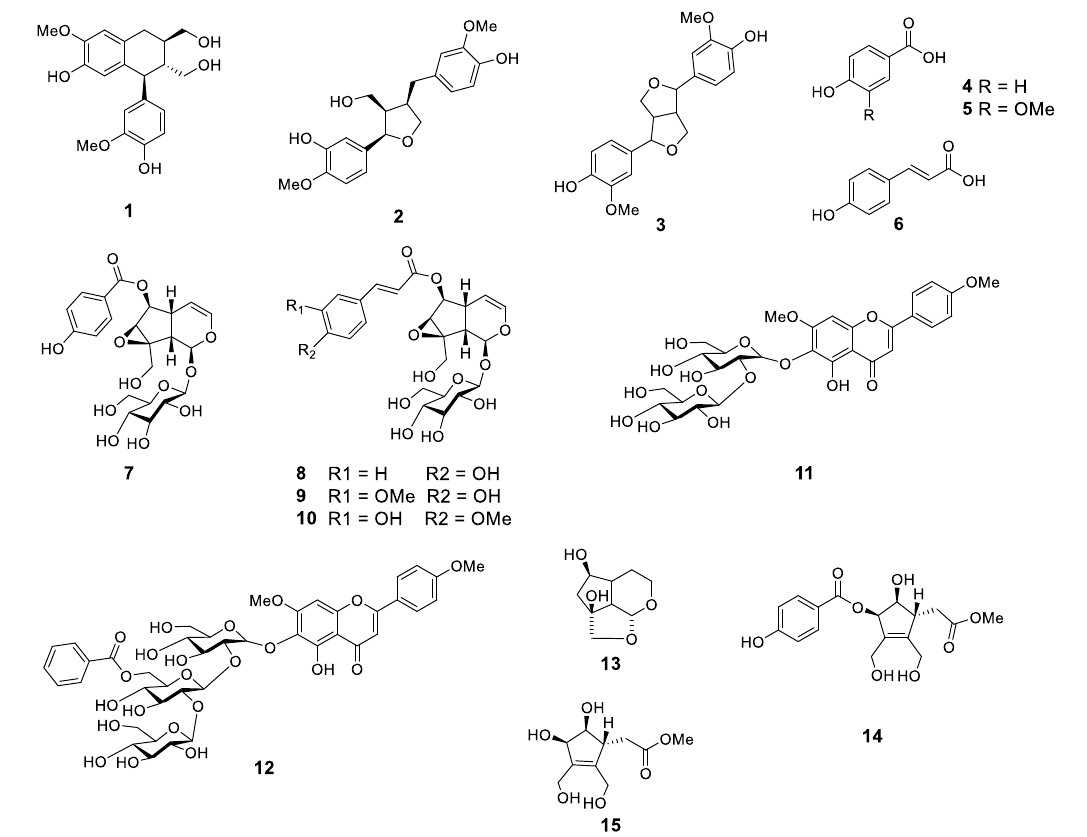
Figure 1. Chemical structures of compounds 1 – 15 . 1 , isolariciresinol; 2 , (+)-lariciresinol; 3 , pinoresinol; 4 , 4-hydroxybenzoic acid; 5 , vanillic acid; 6 , trans - p -coumaric acid; 7 , catalposide; 8 , specioside; 9 , 6- O - trans -feruloyl catalpol; 10 , minecoside; 11 , 5,6-dihydroxy- 7,4′ -dimethoxyflavone-6- O -sophoroside; 12 , 5,6-dihydroxy- 7,4′ -dimethoxyflavone-6- O -[6 ′′′ -benzoyl- β -D-glucopyranosyl-(1 → 2)- β -D-glucopyranosyl-(1 → 2)]- β -D-glucopyranoside; 13 , des- p -hydroxybenzoyl-3-deoxycatalpin; 14 , (7 R )-3-methoxy-(7- O - p -hydroxybenzoyl)eucommic acid; 15 , (7 R )-3-methoxy-hydroxyeucommic acid.